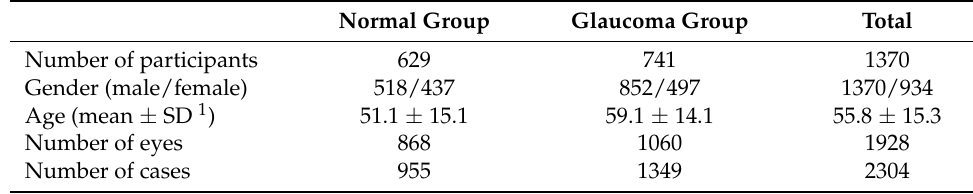
Table 1. Characteristics of the participants.